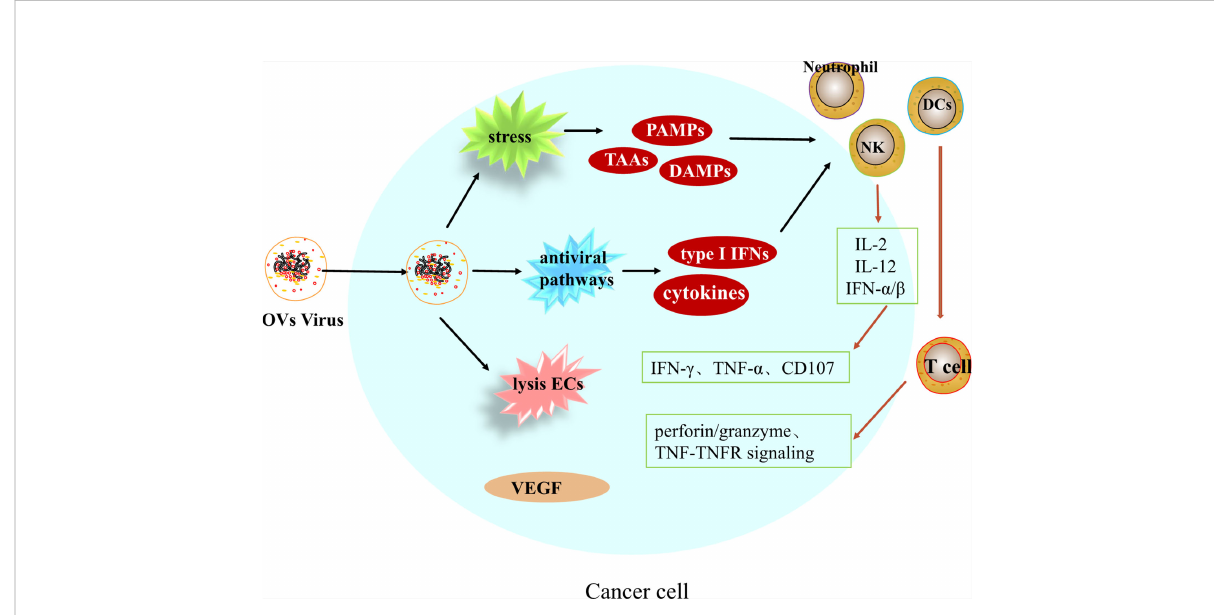
FIGURE 2 Multiple effects of oncolytic viruses on the tumor